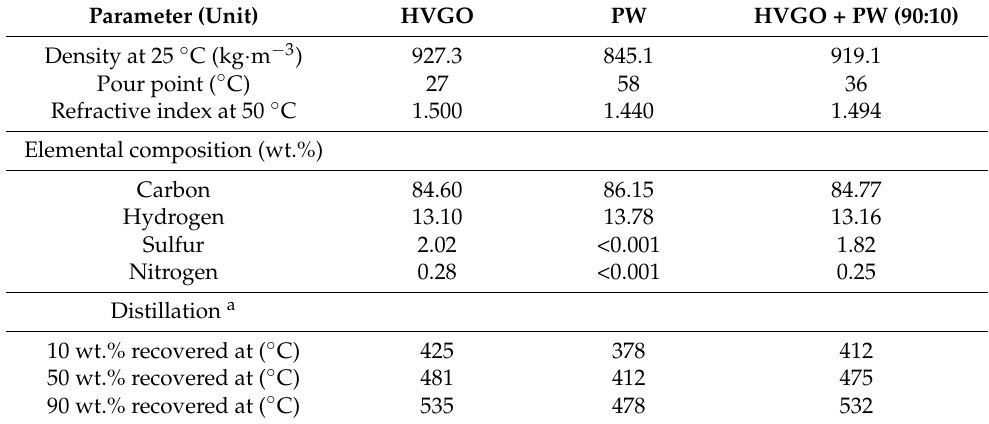
Table 1. Basic physico-chemical properties of raw materials used in hydrocracking experiments.